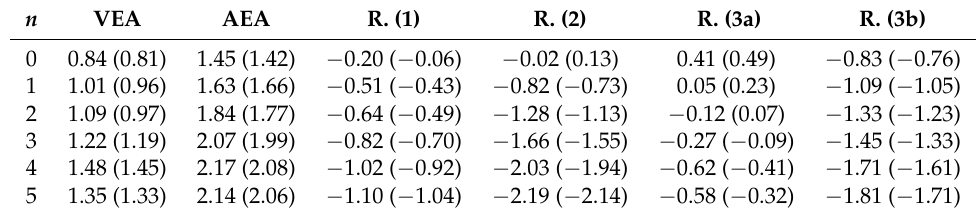
Table 2. Reaction energies (in eV) for electron attachment and DEA reactions for MISO(H 2 O) n clusters in dependence on the number of hydrated water molecules. Reaction energies are given with respect to isomers I shown in Figure 3. Calculated at the B3LYP+D2/aug-cc-pVDZ (M06/aug-cc-pVDZ)